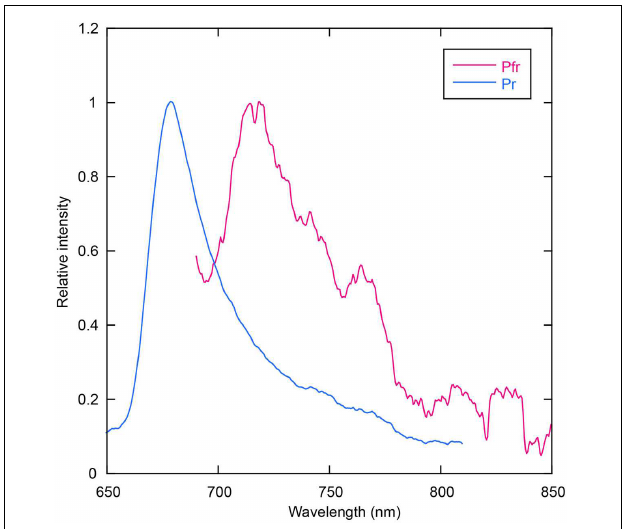
FIGURE 8 | Fluorescence spectra of AM1_C0023g2-BV Pfr (magenta) and AM1_C0023g2-PCB Pr (blue).